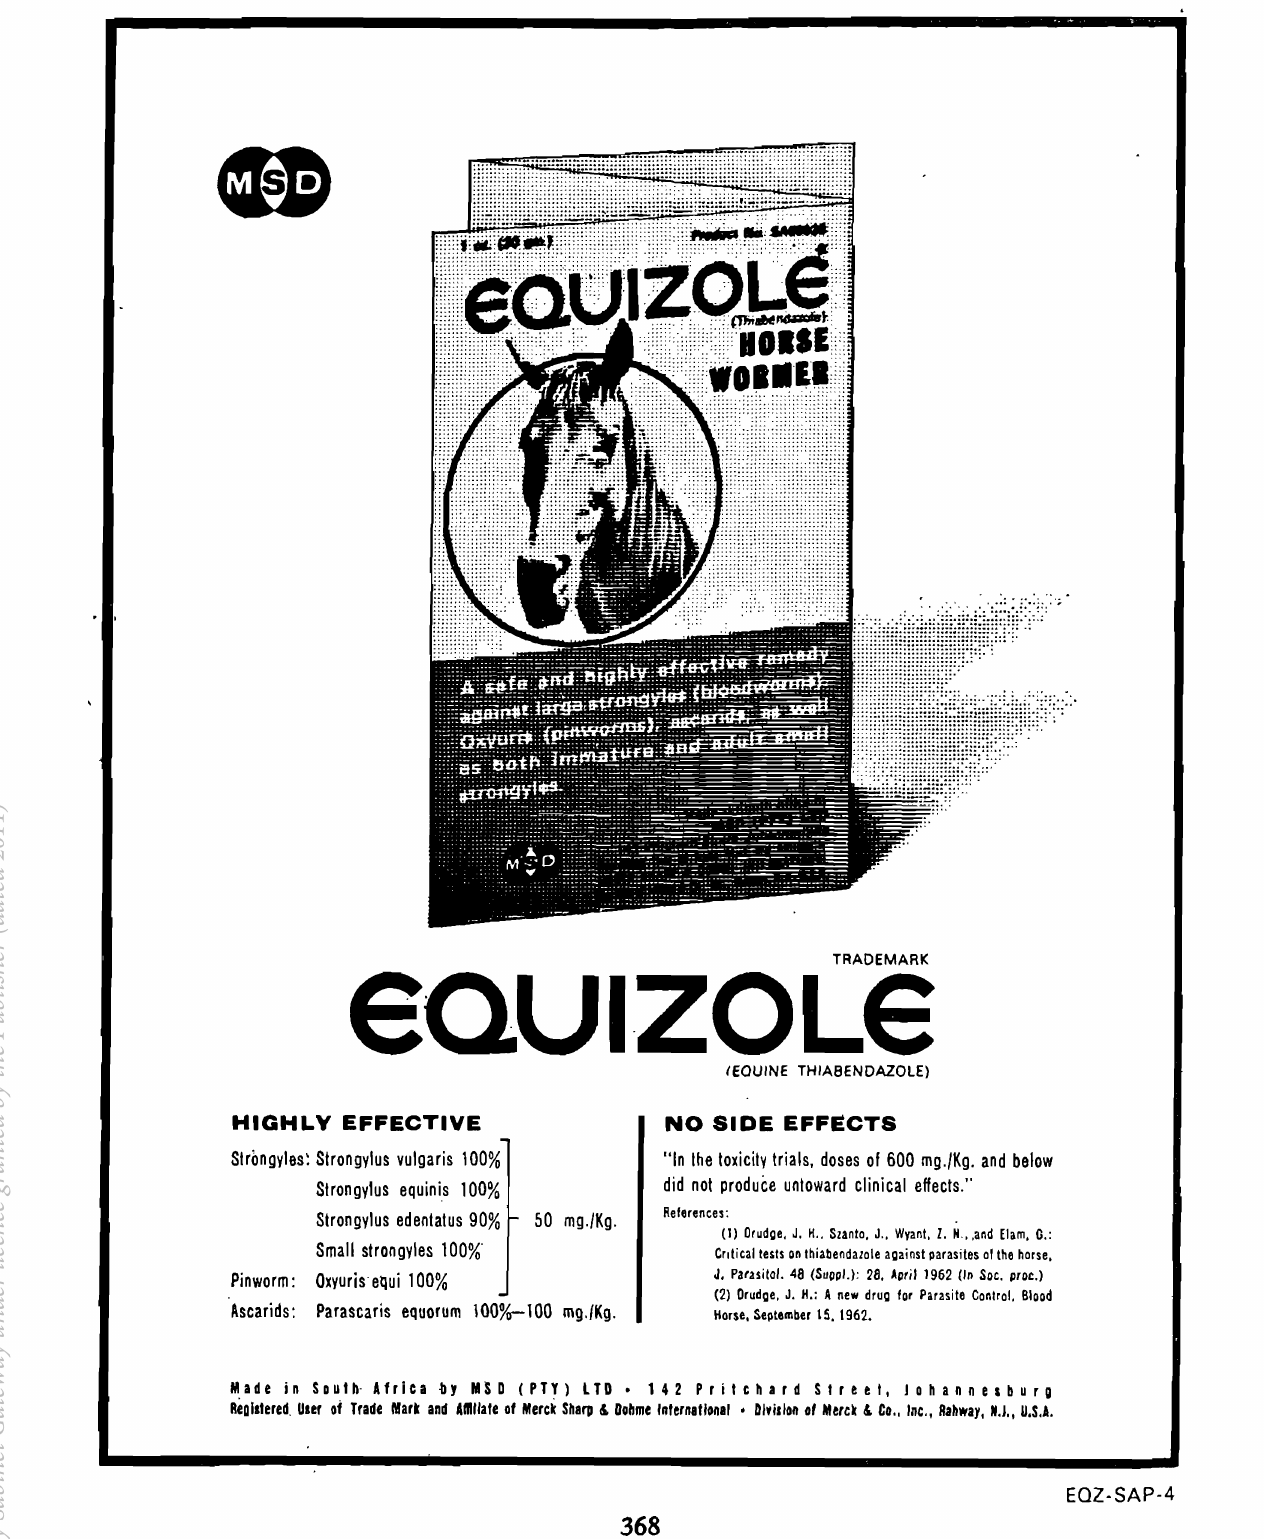
did not produce untoward clinicat